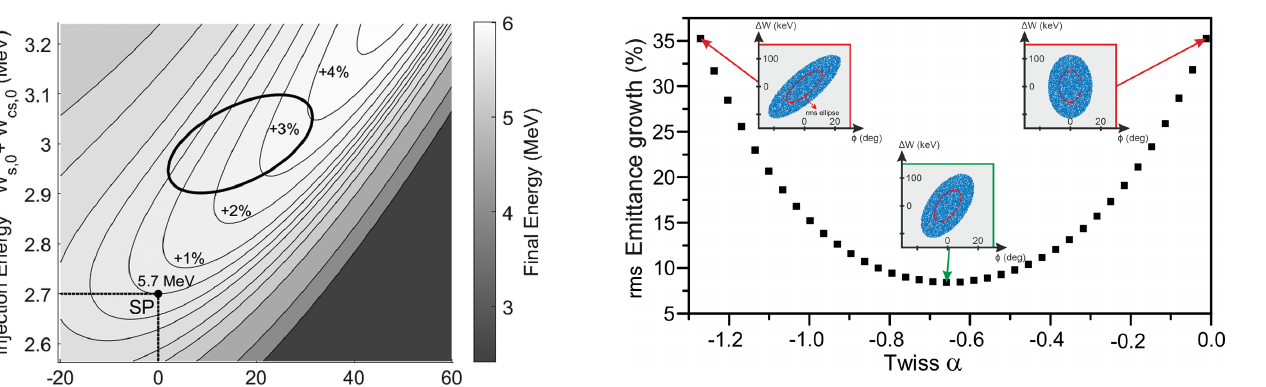
FIG. 9. Simulated emittance growth rate for emittance areas injected at different Twiss parameters α .